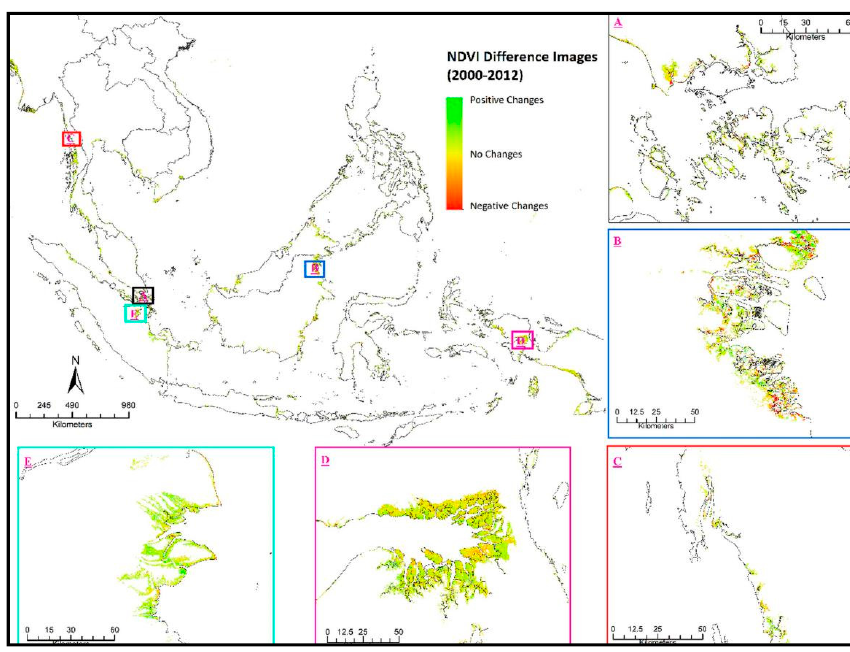
Figure 3. NDVI change between 2000 and 2012 in mangrove area. (A) NDVI decrease in Singapore. (B) NDVI decrease in North Kalimantan. (C) NDVI decrease in West Thailand. (D) NDVI increase in West Papua. (E) NDVI increase in South Sumatra.